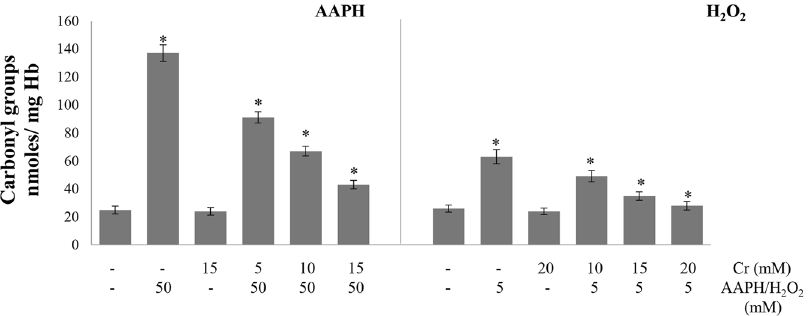
Fig 3. Effect of creatine on AAPH/ H 2 O 2 -induced protein oxidation. Erythrocytes were treated with the indicated concentrations of H 2 O 2 /AAPH, in presence and absence of Cr. Carbonyl content was determined in hemolysates as an index of protein oxidation. Results are mean values ± SEM from six independent experiments using blood from different donors. * Significantly different from control (p <